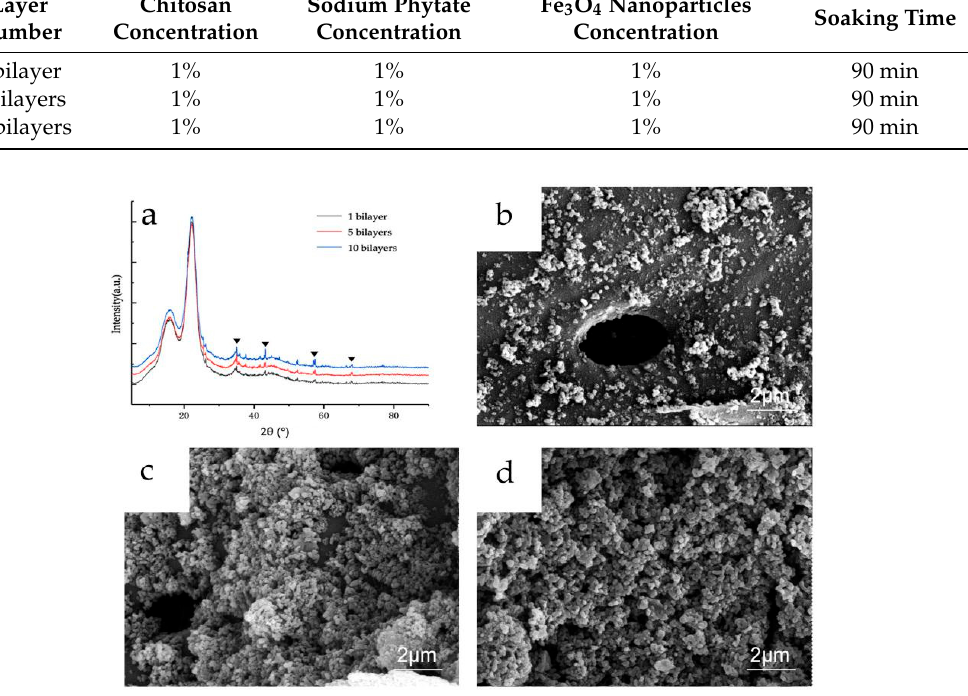
Figure 5. ( a ) XRD patterns of different numbers of alternating sedimentary layers at room temperature: 1 (black), 5 (red), and 10 bilayers (blue); high-magnification SEM images of chitosan/sodium phytate/nano-Fe 3 O 4 composite coatings on wood surfaces obtained by different numbers of alternating sedimentary layers at room temperature: ( b ) 1 bilayer, ( c ) 5 bilayers, and ( d ) 10 bilayers.